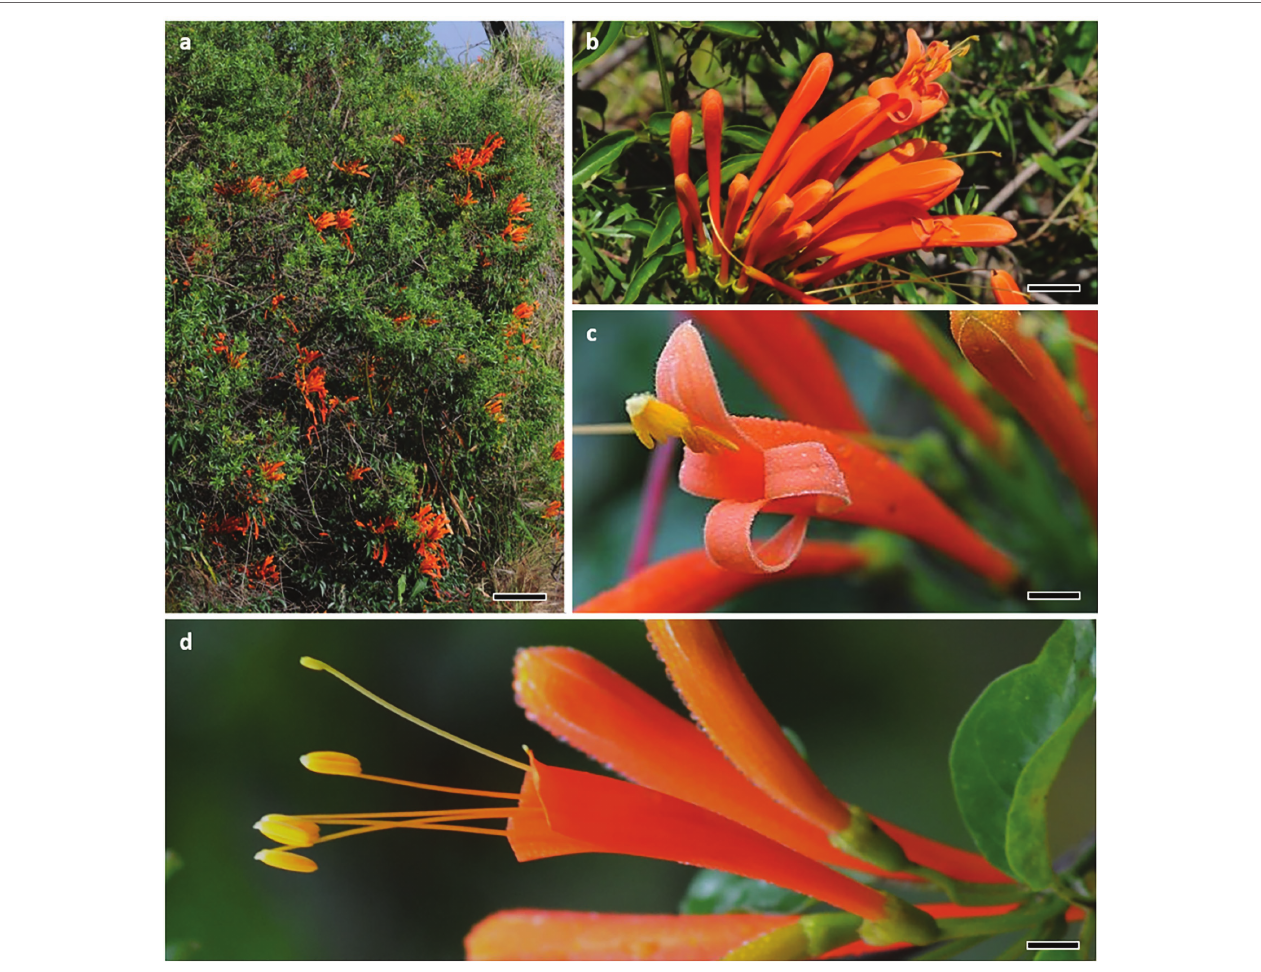
FIGURE 1 | Pyrostegia venusta . (A) Flowering plant. Scale bar: 20 cm. (B) Inflorescence with undamaged open flowers and flower buds. Scale bar: 2.5 cm. (C) Recently opened flower. Scale bar: 0.8 cm. (D) Natural floral damage corresponding to 51–60% of the corolla. Scale bar: 0.5